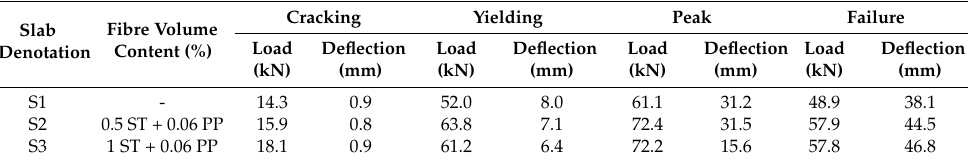
Figure 7. Load-deflection responses for experimental slabs. Table 4. Load and deflection response results for slabs. Table 4. Load and deflection response results for slabs.